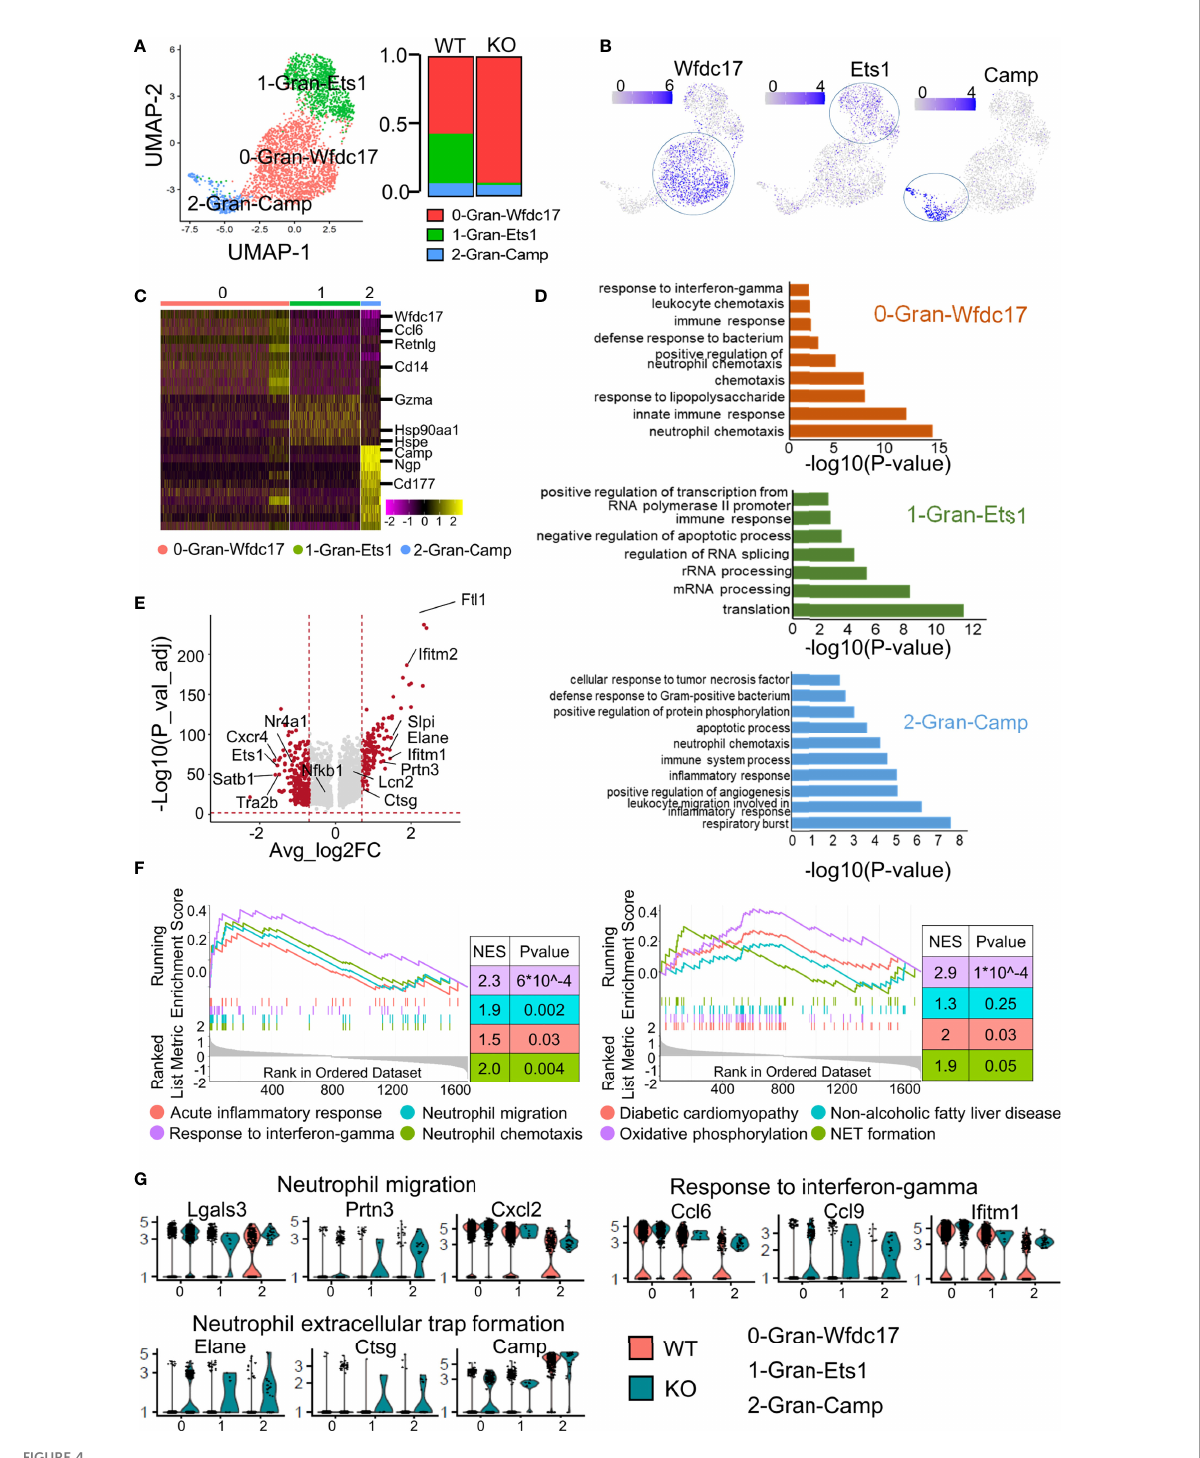
FIGURE 4 Subclustering of granulocytes revealed more effector neutrophils in the ApoA4 knockout group. (A) UMAP plot of liver granulocytes showing a three-cluster distribution; fraction of each granulocyte subset in the WT and KO. (B) Feature plots of marker gene expression in three subsets. (C) Heatmap of the 6 most upregulated genes (decreased by P value ) among the three granulocyte subsets. (D) GO BP terms enriched in the indicated subsets; the gene list is the maker genes of each cluster. (E) Volcano plot showing upregulated genes in WT and KO granulocytes. Average_log 2 fold change > 0.7 & -log 10 ( P value-adjust) > 2 are red; others are grey. (F) GSEA plot of 8 MSigDB hallmark gene sets. (G) Violin plots showing the expression of genes involved in neutrophil migration, response to interferon-gamma, and NET formation pathways among granulocyte